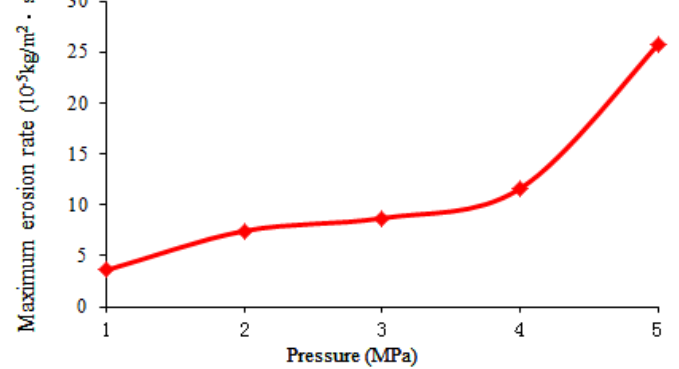
Figure 7. Curve of the maximum erosion rate versus pressure.